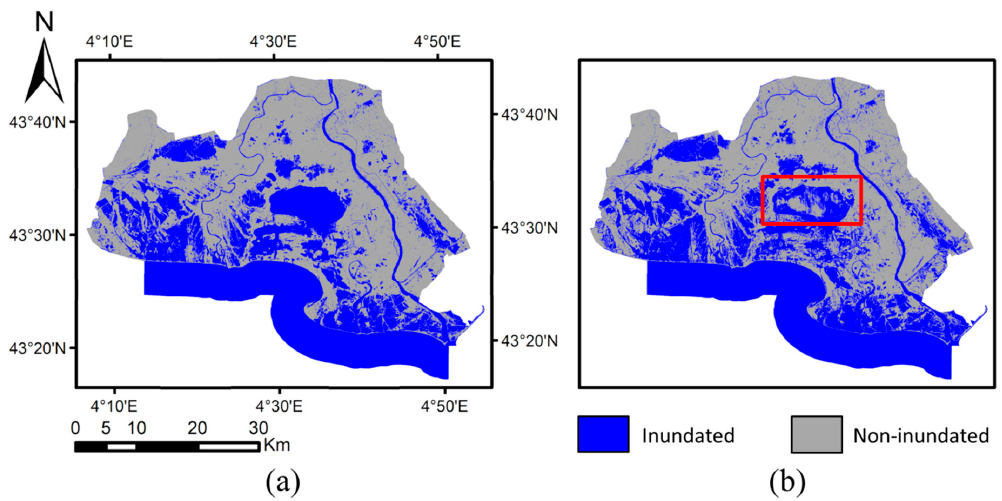
Figure 12. Inundation map generated on 14 November, 2017 using: ( a ) “Alt2 (agv)”, and ( b ) reference map. Blue and gray colors correspond to inundated and non-inundated areas, respectively.